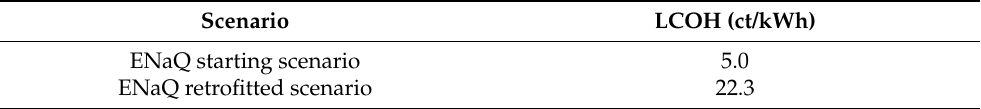
Table 7. Levelized cost of heat for ENaQ starting and ENaQ retrofitted